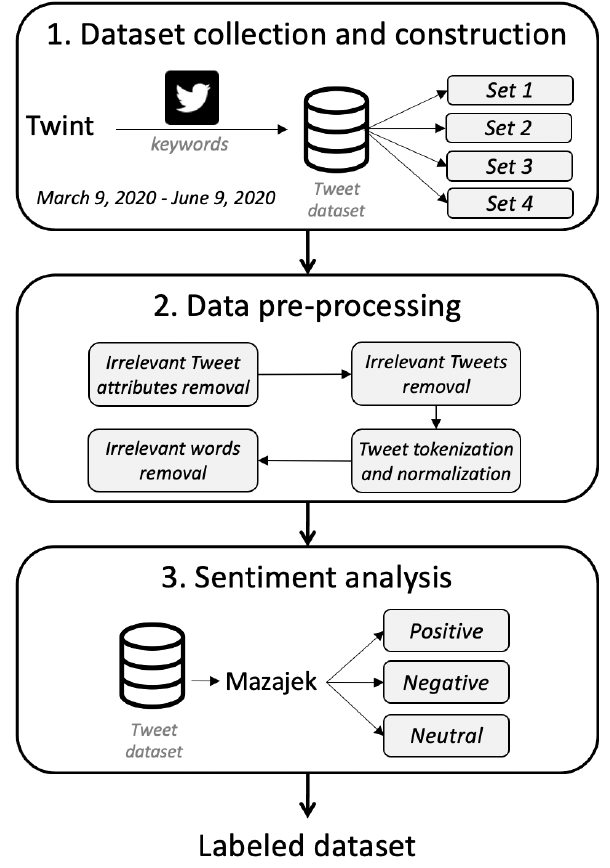
Figure 1. Pipeline of the